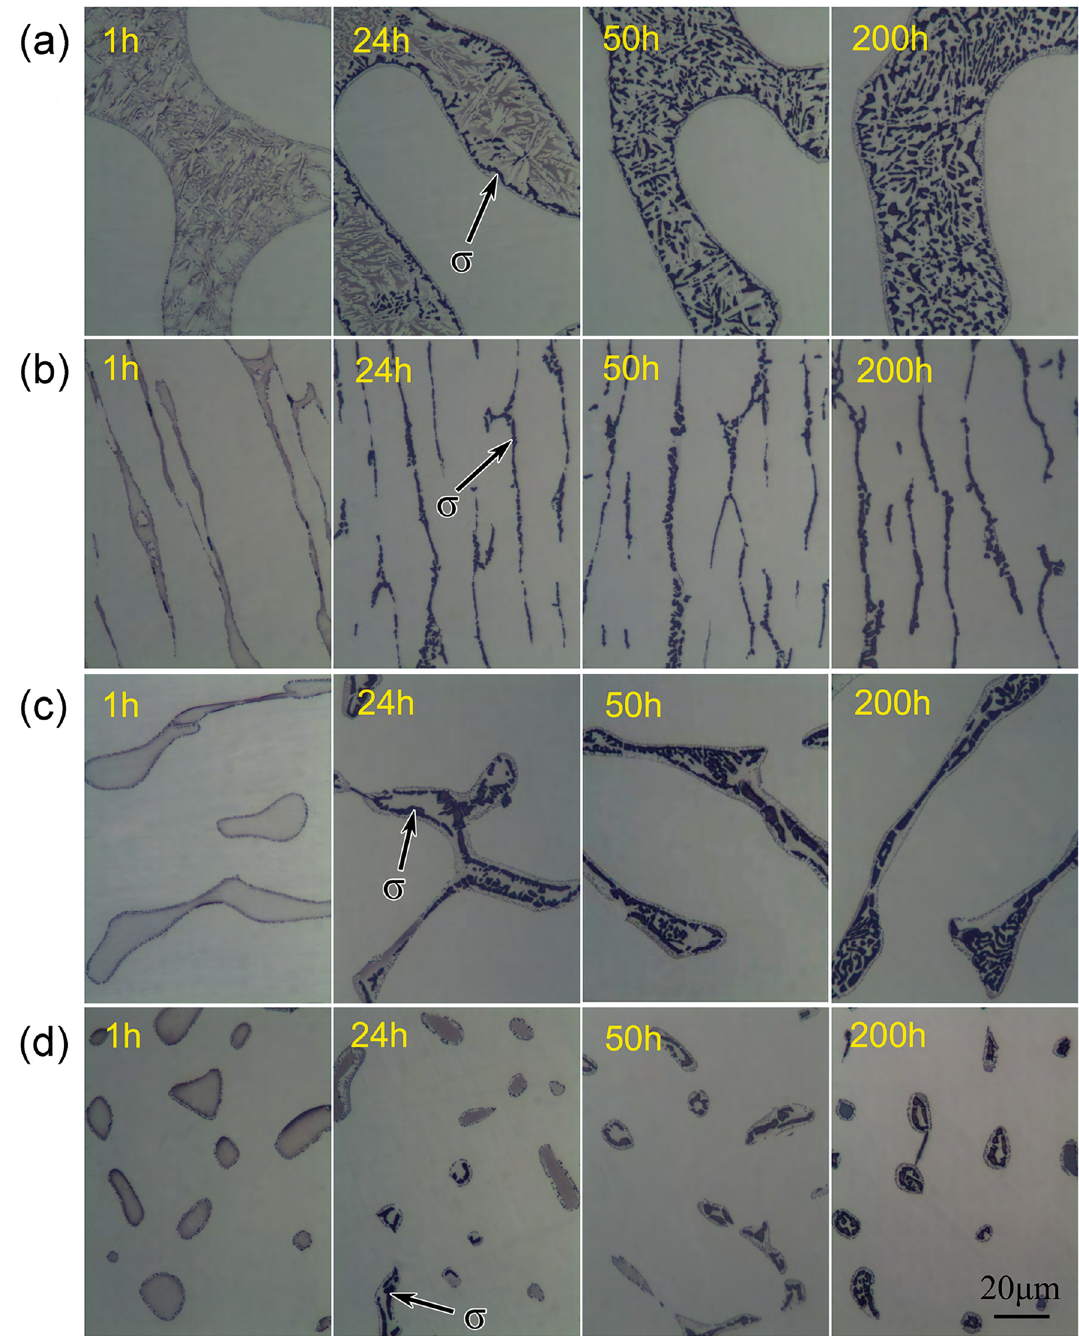
Figure 5. OM photographs of Z3CN20.09M specimens with different microstructure aged at 750°C for different times (a) specimen A, (b) specimen B, (c) specimen C, (s) specimen D. (specimen B) is the fastest. The faster formation, while, takes place in specimen with aggregated larger and more ferrite (specimen C). 3. The lowest level Cr content in ferrite and fewest α/γ interfaces in specimen are the reason for the